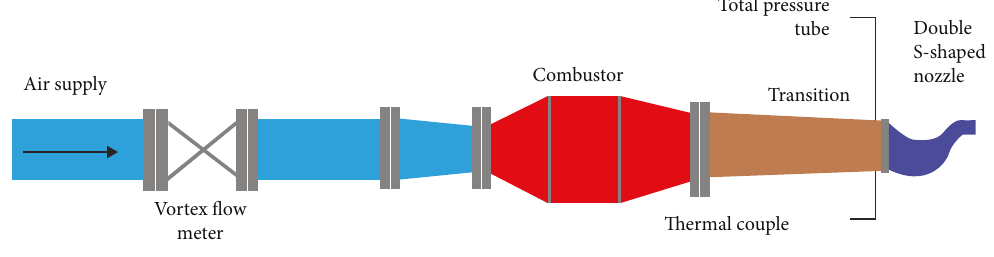
Figure 4: Schematic diagram of the experimental